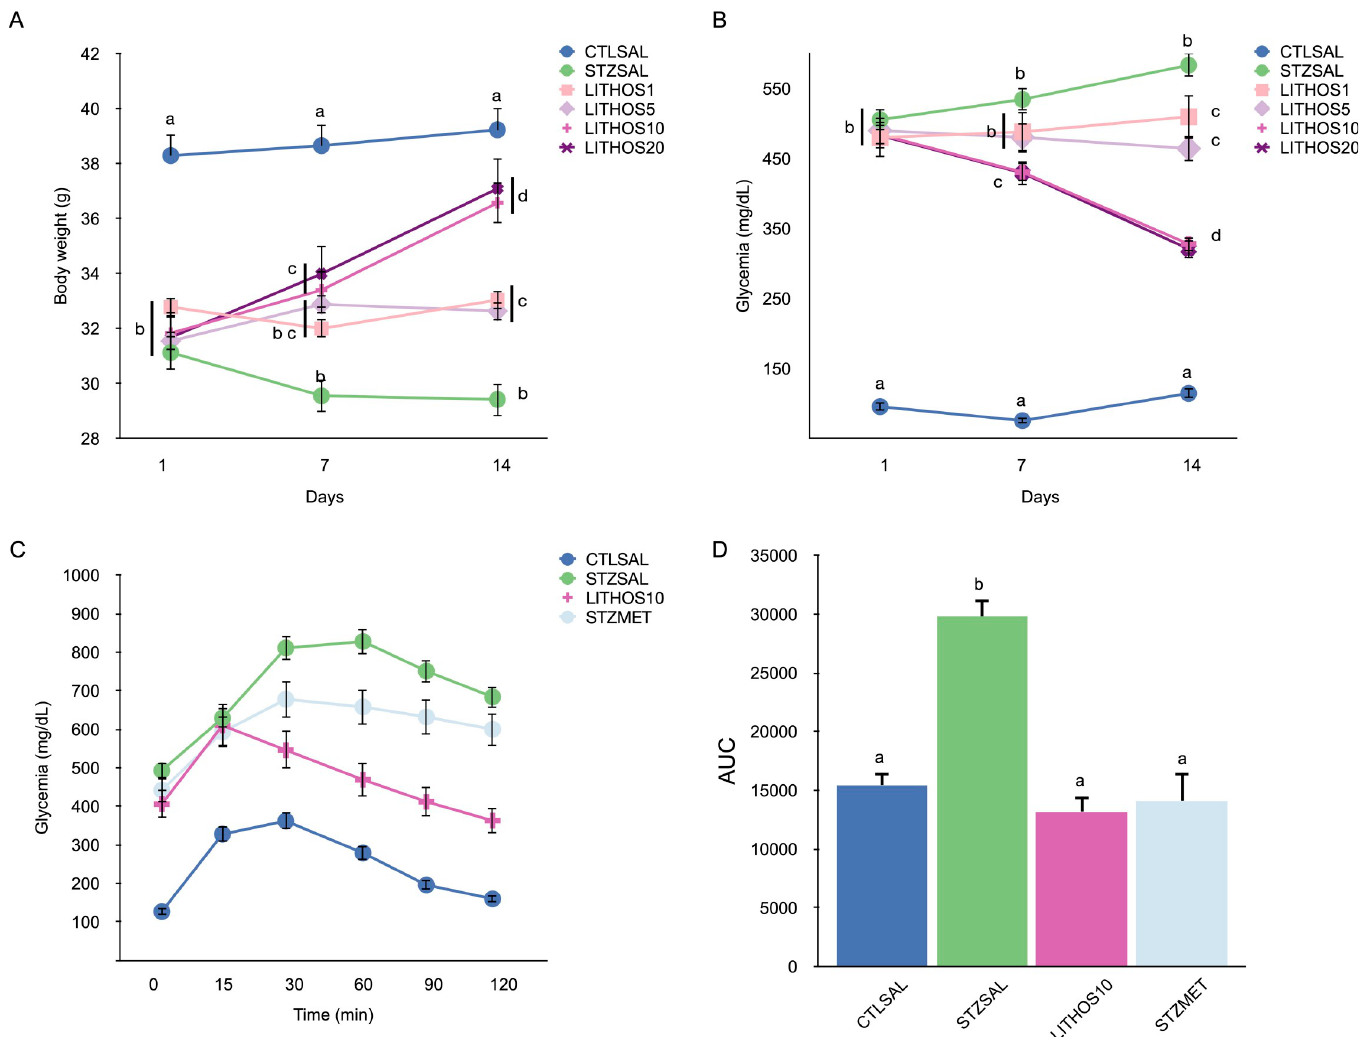
Fig 5. Effect of lithospermoside ( 3 ) at the doses of 1, 5, 10, and 20 mg/kg b.w. treatment on ( A ) body weight ( B ) on fasting blood glucose ( C ) at dose 10 mg/kg b.w. on glucose tolerance test and ( D ) area under the curve. The results are expressed as means ± SEM (n = 10/group). Different letters indicate significant differences between groups. ANOVA followed by Tukey- post-test , p <